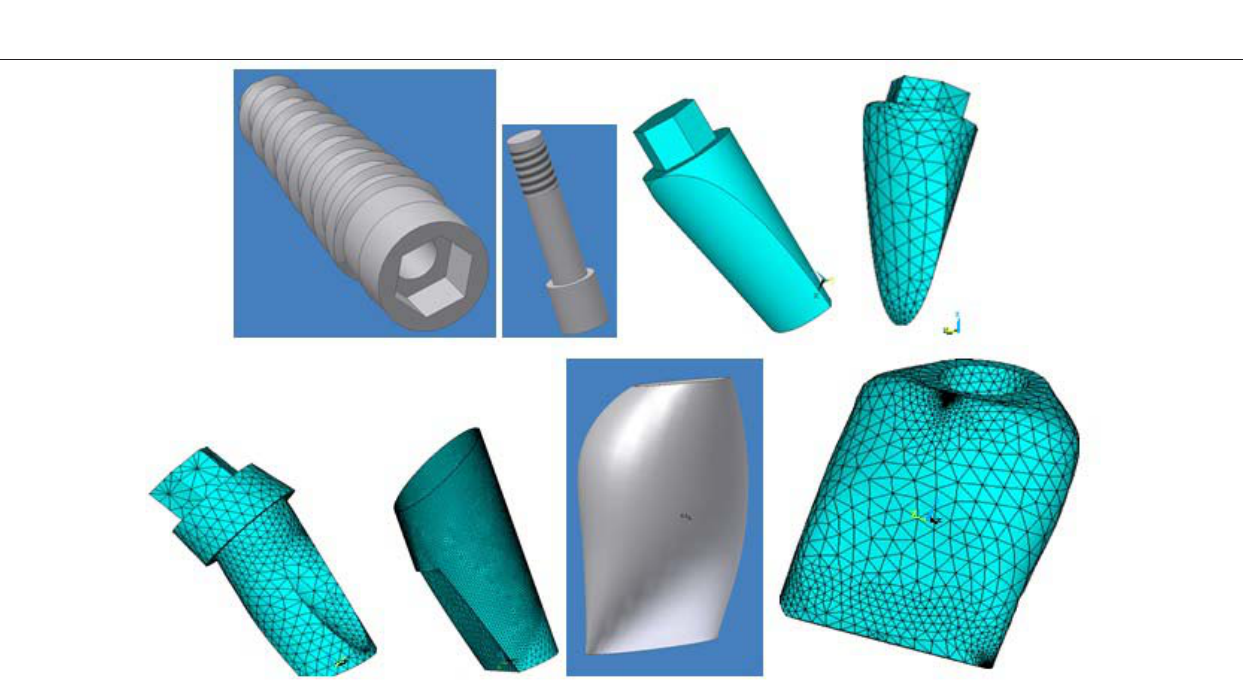
Fig. 1: Modeled and meshed components (implant, screw, GP, abutment, cement layer, crown) screen shots from Inventor / ANSYS screens